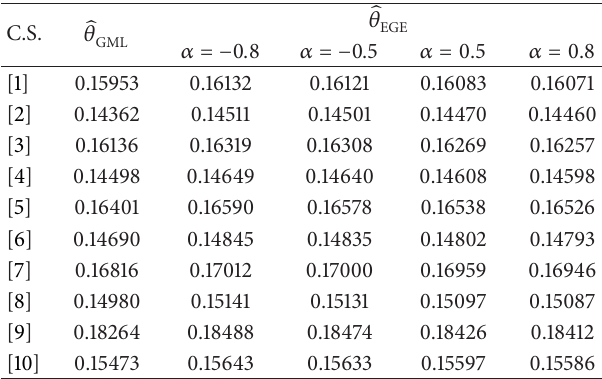
Table 2: GML and EB estimates of parameter 𝜃 for different values of 𝛼